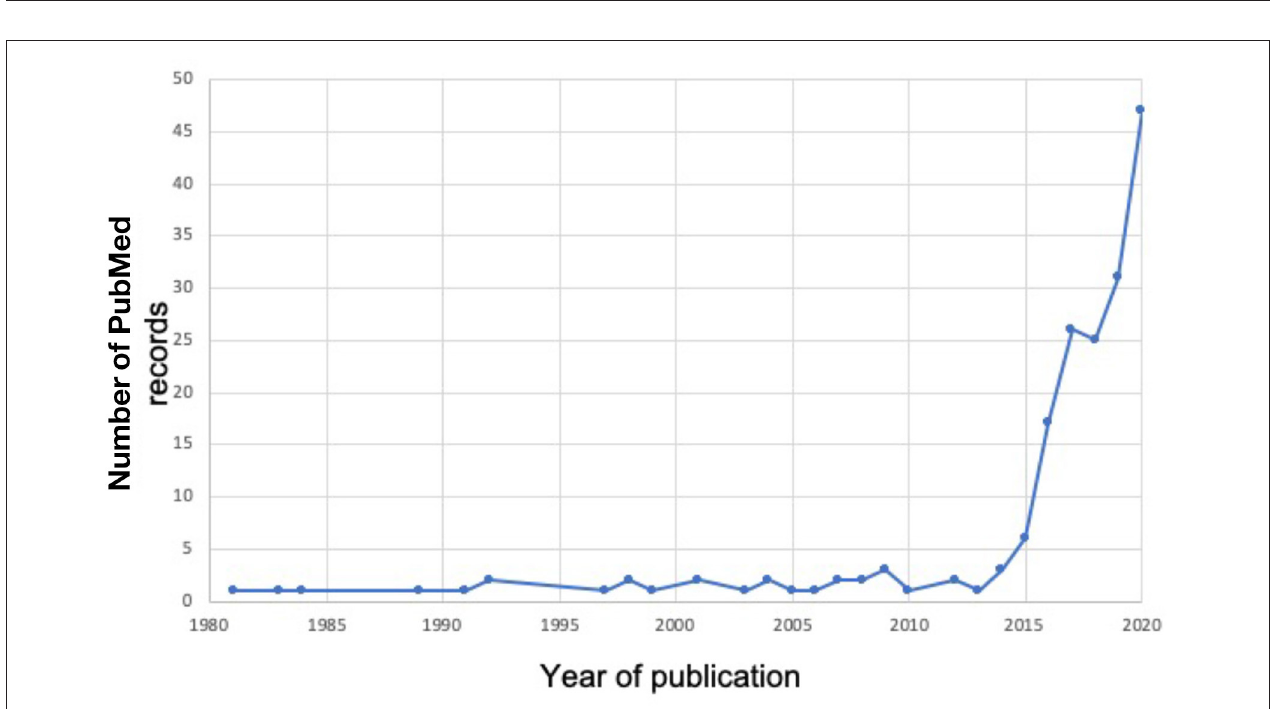
FIGURE 2 | Number of PubMed listed publications per year related to the topic Acute: Chronic Workload Ratio (ACWR) between 1980 and 2020. The following search was applied in the electronic database PubMed (“acute to chronic work load ratio” OR ACWR).